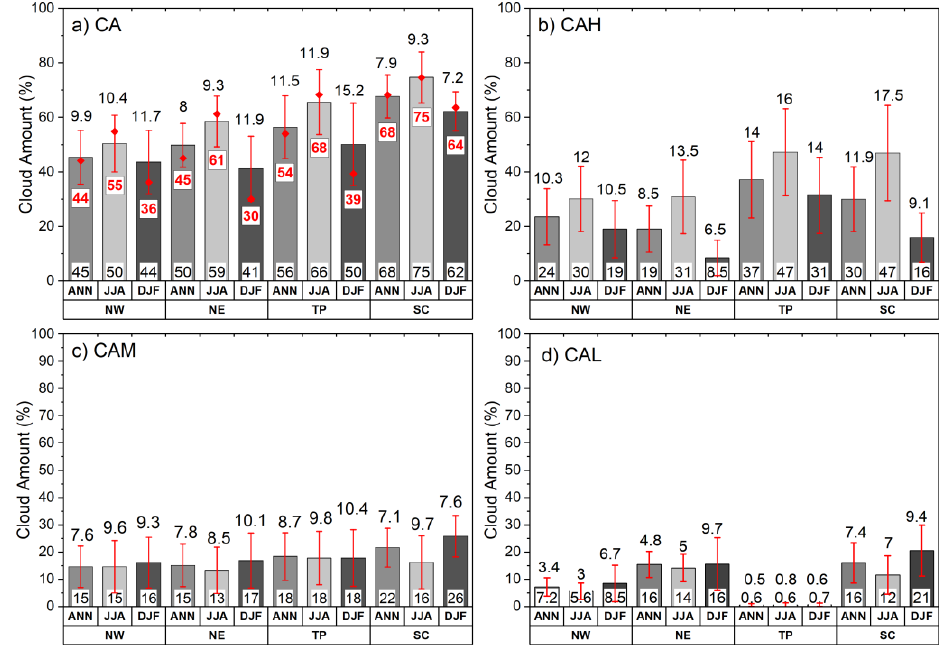
Figure 3. The annual average (ANN), summer (JJA) and winter (DJF) TCA of satellite cloud products in different regions of China and the mean and standard deviation of the cloud amount of high-, mid- and low-level clouds, unit: %. ( a ) CA: total cloud amount, ( b ) CAH: high-level cloud amount, ( c ) CAM: mid-level cloud amount, ( d ) CAL: low-level cloud amount, where CAH + CAM + CAL = CA. Red line segments represent standard deviations across all satellite datasets, and the numbers shown at the bottom of the histogram represent the mean of all satellite datasets; red triangles represent site-observed values.